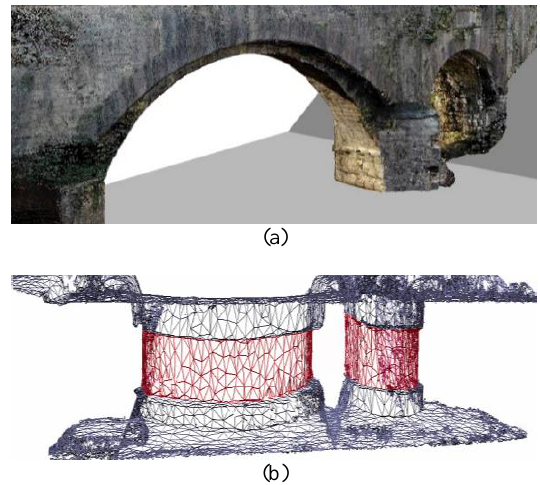
Figure 7. 3D representation of the arches of the bridge a) 3D of the San Cono’s bridge arches; b) Plan view in wireframe mode of the (decimalized) mesh of the arches